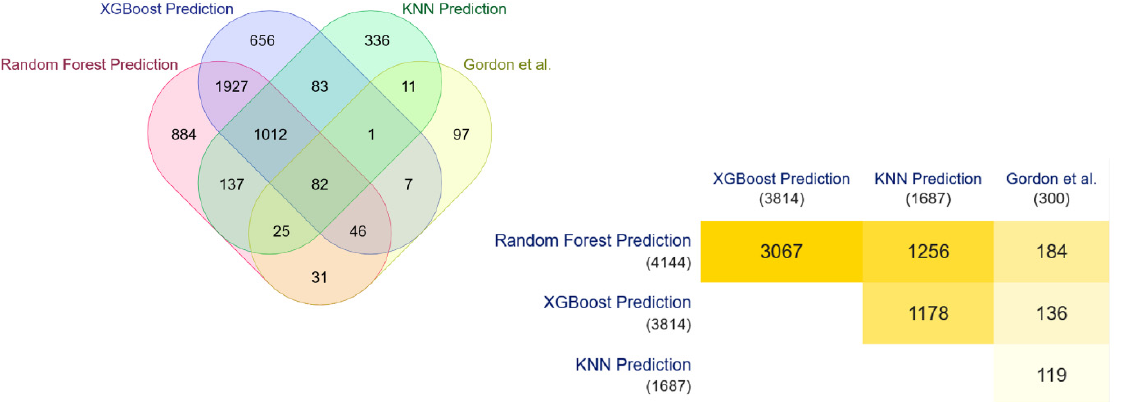
Figure 5. Overlapping of XGBoost and other methods predicted COVID-19 human drug targets.